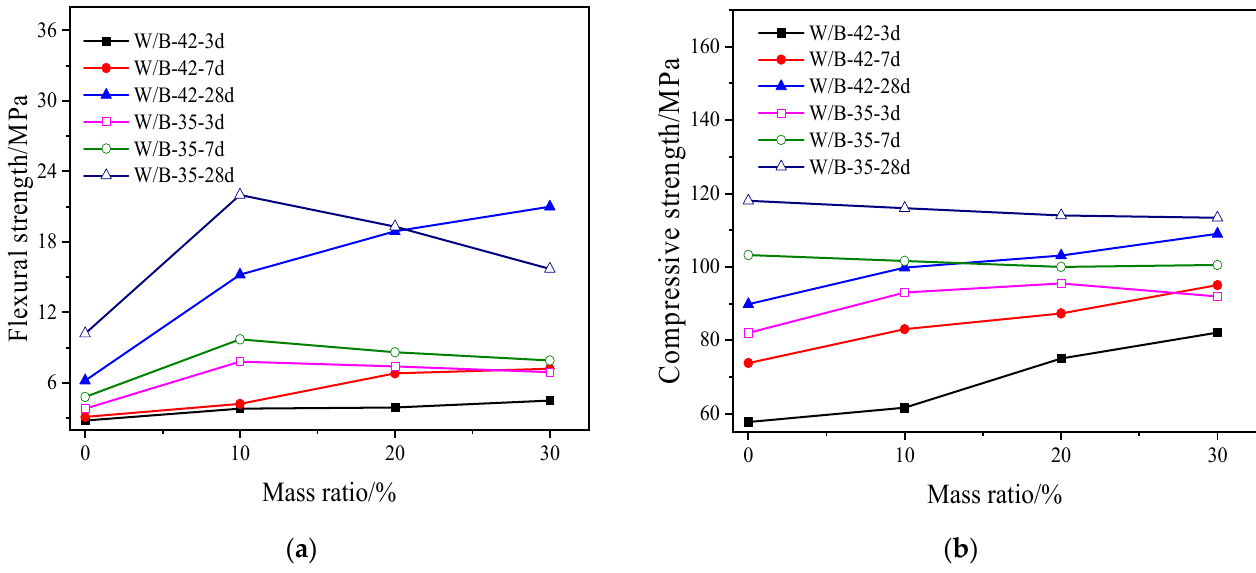
Figure 4. The mechanical strengths of activated blast furnace slag powder with MgO. ( a ) Flexural strength. ( b ) Compressive strength.